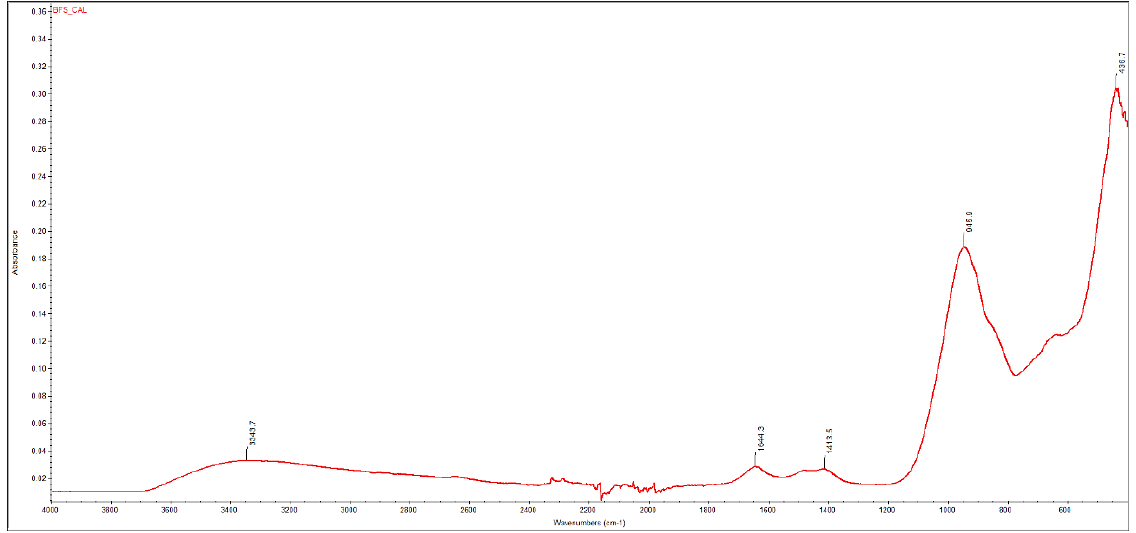
Figure 3. The result of FTIR using 100 %